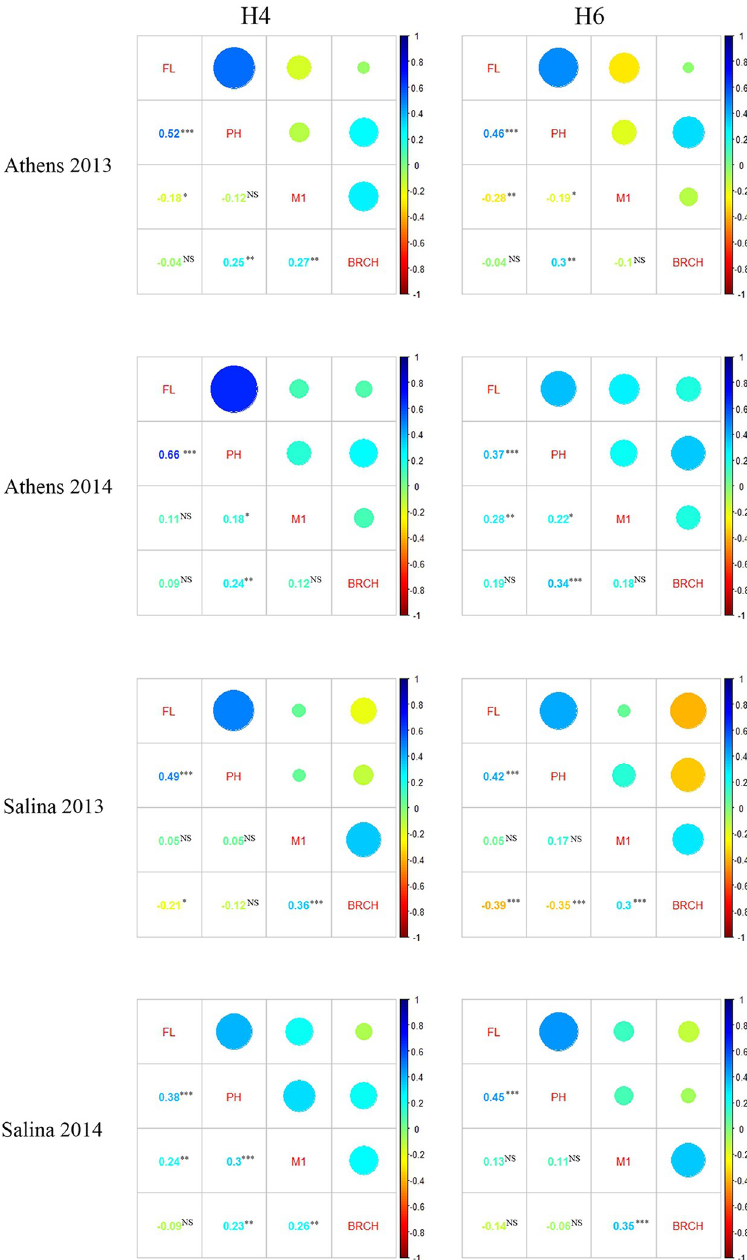
Fig 2. Correlation coefficients among days to flowering (FL), plant height (PH), number of mature tillers (TL) and number of secondary branches (BRCH) in the H4 and H6- derived SBSH-BC 1 F 2 populations in four